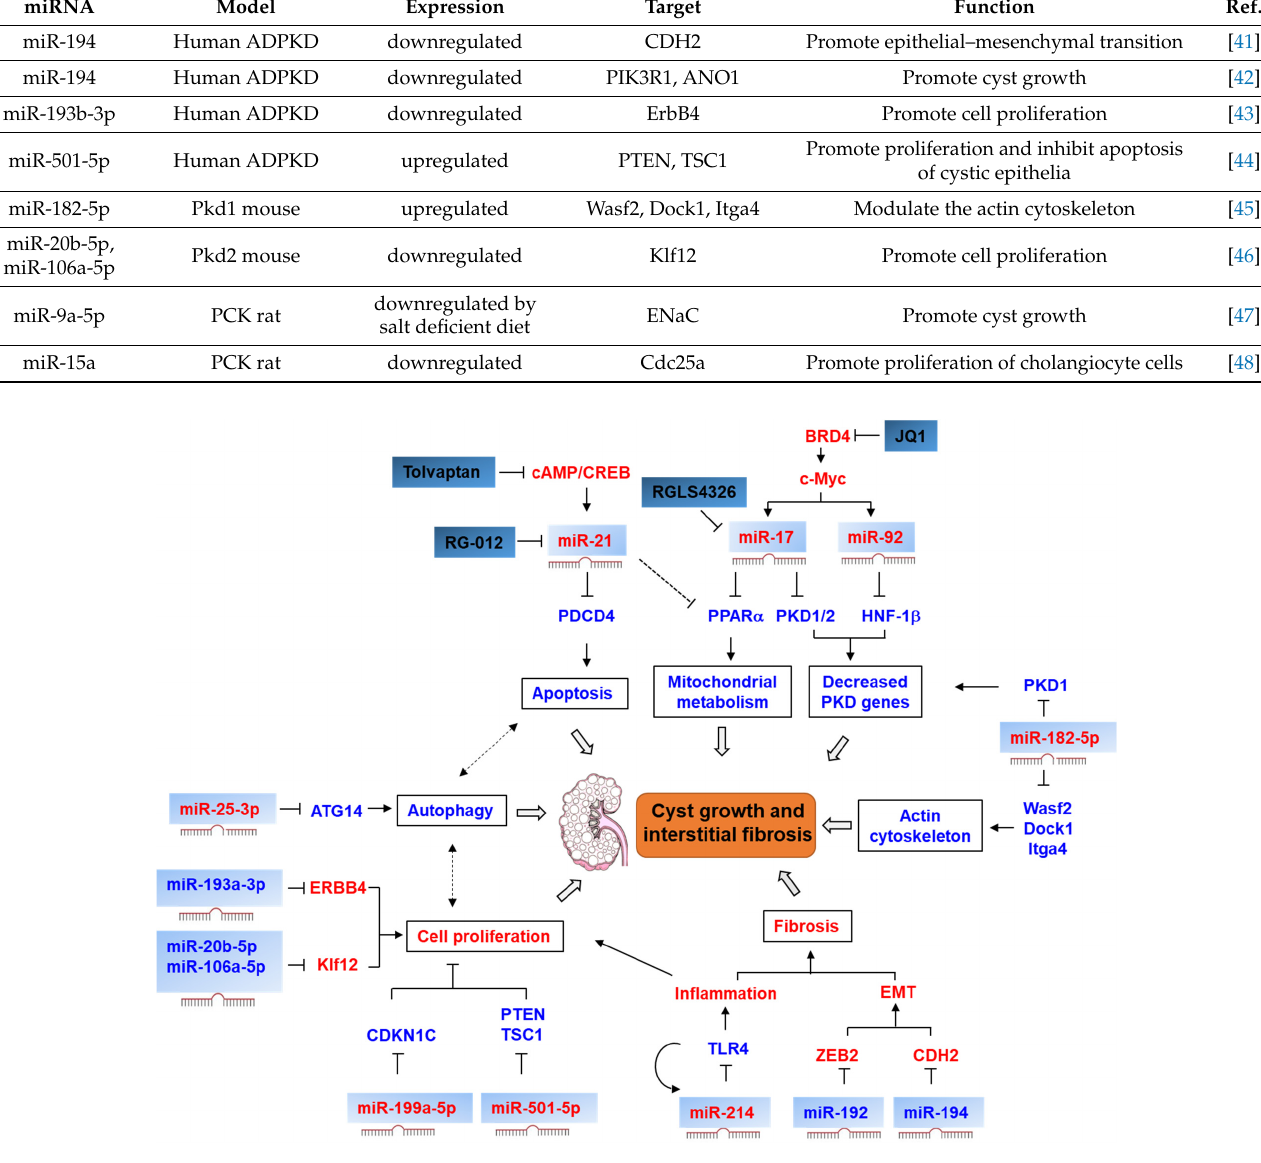
Figure 2. Signaling pathways modulated by miRNAs in autosomal dominant polycystic kidney disease (ADPKD). In ADPKD, miR-21 is upregulated by cAMP/CREB signaling, which represses the expression of PDCD4 to inhibit cystic renal epithelial cell apoptosis. The expression of miR-17 and miR-19 is transcriptionally activated by c-Myc, and the upregulation of miR-17 results in a defect of mitochondrial metabolism by repressing proliferator-activated receptor- α (PPAR α ). Furthermore, miR-17 represses the expression of PKD1 and PKD2 , and miR-92 represses the expression of HNF-1 β . The upregulation of miR-25-3p inhibits autophagy by targeting ATG14. The downregulation of miR-193a-3p promotes cell proliferation through derepressing the expression of ERBB4. The downregulation of miR-20b-5p and miR-106-5p increases cell proliferation through derepressing the expression of Kif12. The upregulation of miR-199a-5p and miR-501-5p promotes cell proliferation through targeting CDK1N1C, PTE and TSC1, respectively. The upregulation of miR-214 inhibits inflammation through targeting TLR4. The downregulation of miR-192 and miR-194 promotes epithelial–mesenchymal transition (EMT) through targeting ZEB2 and CDH2. The upregulation of miR-182-5p decreases the expression of PKD1 and leads to defects of actin cytoskeleton through targeting Wasf2, Dock1 and Itga4. Tovalptan, a vasopressin receptor antagonist. JQ1, a BRD4 inhibitor. RG-012, an anti-miR targeting miR-21. RGLS4326, an anti-miR target miR-17. The upregulation or activation of miRNAs and signaling pathways in ADPKD is marked in red . The downregulation or inhibition of signaling pathways in ADPKD is marked in blue . Arrows indicate a positive effect. “T” indicates a negative effect. Dashed lines indicate putative signaling pathways and